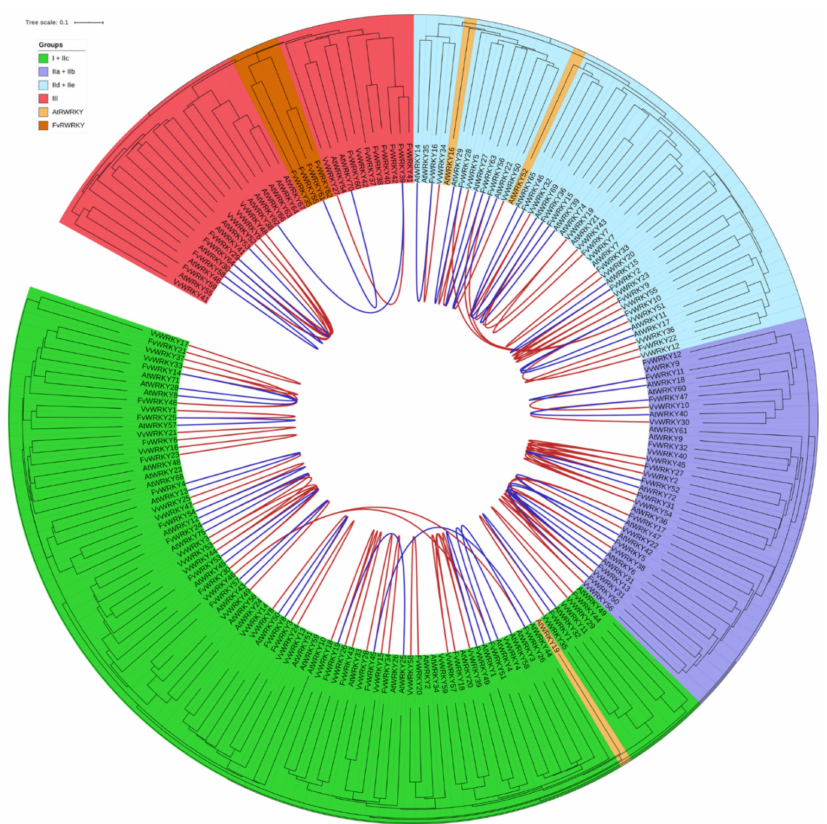
Figure 5. Phylogenetic analysis of Fragaria vesca (Fv), Arabidopsis thaliana (At) and Vitis vinifera (Vv) WRKY proteins. WRKY proteins are clustered into Groups I + IIc, IIa + IIb, IId + IIe and III. R protein-WRKY from Fv and At are clustered within their respective groups. The tree was inferred using the Neighbor-Joining method (1000 bootstrap replicates) and drawn to scale, with branch lengths in the same units as those of the evolutionary distances used to infer the phylogenetic tree. The evolutionary distances were computed using the p-distance method and are in the units of the number of amino acid differences per site. All positions with less than 95% site coverage were eliminated. Connecting lines represent shared synteny between Fv-Vv (red) and Fv-At